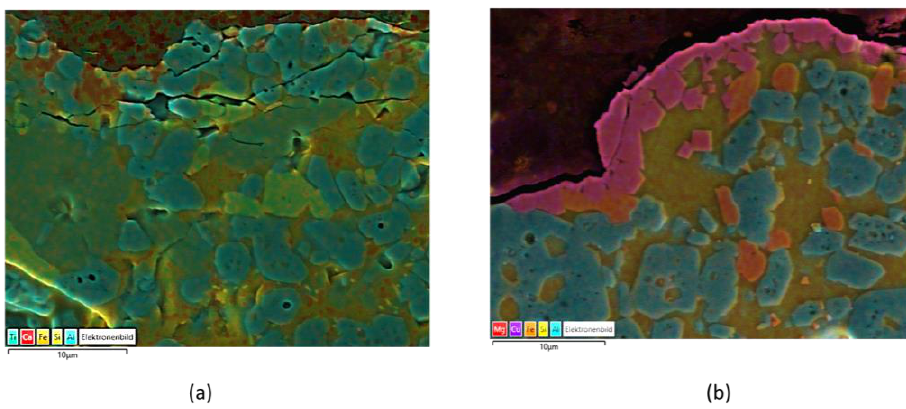
Figure 5. SEM/EDS Mapping of bauxite proppant BL 1630 ( a ) before and ( b ) after black spinel coating.